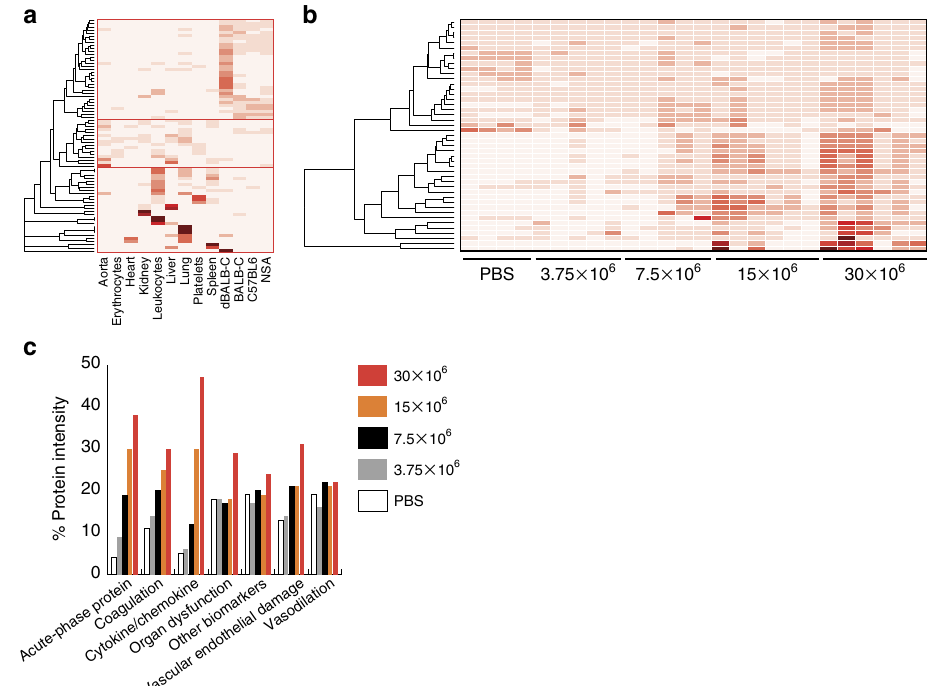
Figure 6 | Abundance differences of known sepsis biomarkers. Previously tested human sepsis biomarkers 23 were mapped to corresponding mouse orthologues identified in this study. ( a ) Heat-map indicating protein distribution of identified biomarkers across the analysed organs, cells and plasma based on scaled spectral counts from LC-MS/MS analysis. ( b ) Quantitative DIA-MS protein profiles of all identified biomarkers in blood plasma from the inoculated animals. Previous reports have grouped the putative biomarkers in annotated functional classes. The total intensity of the quantified proteins associated with specific annotated biomarker classes for the separate dose groups was summed up. ( c ) Total intensity quantitative changes for the annotated biomarker classes for the dose